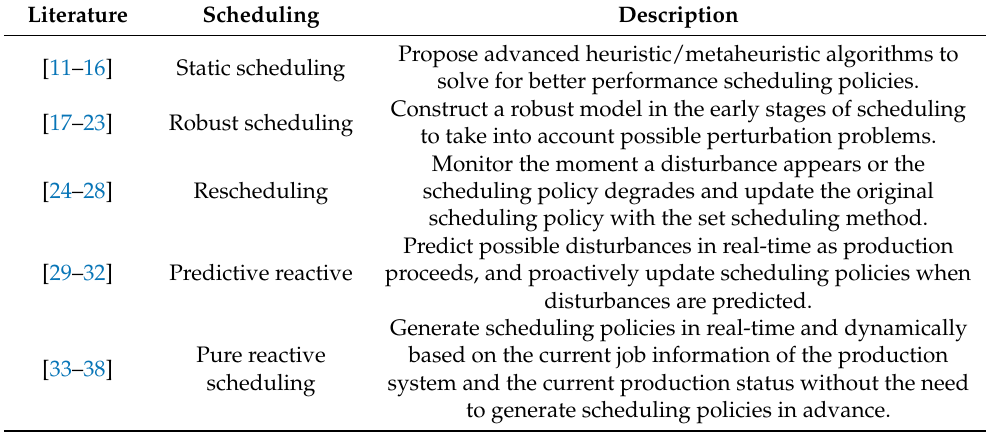
Table 1. Summary of the